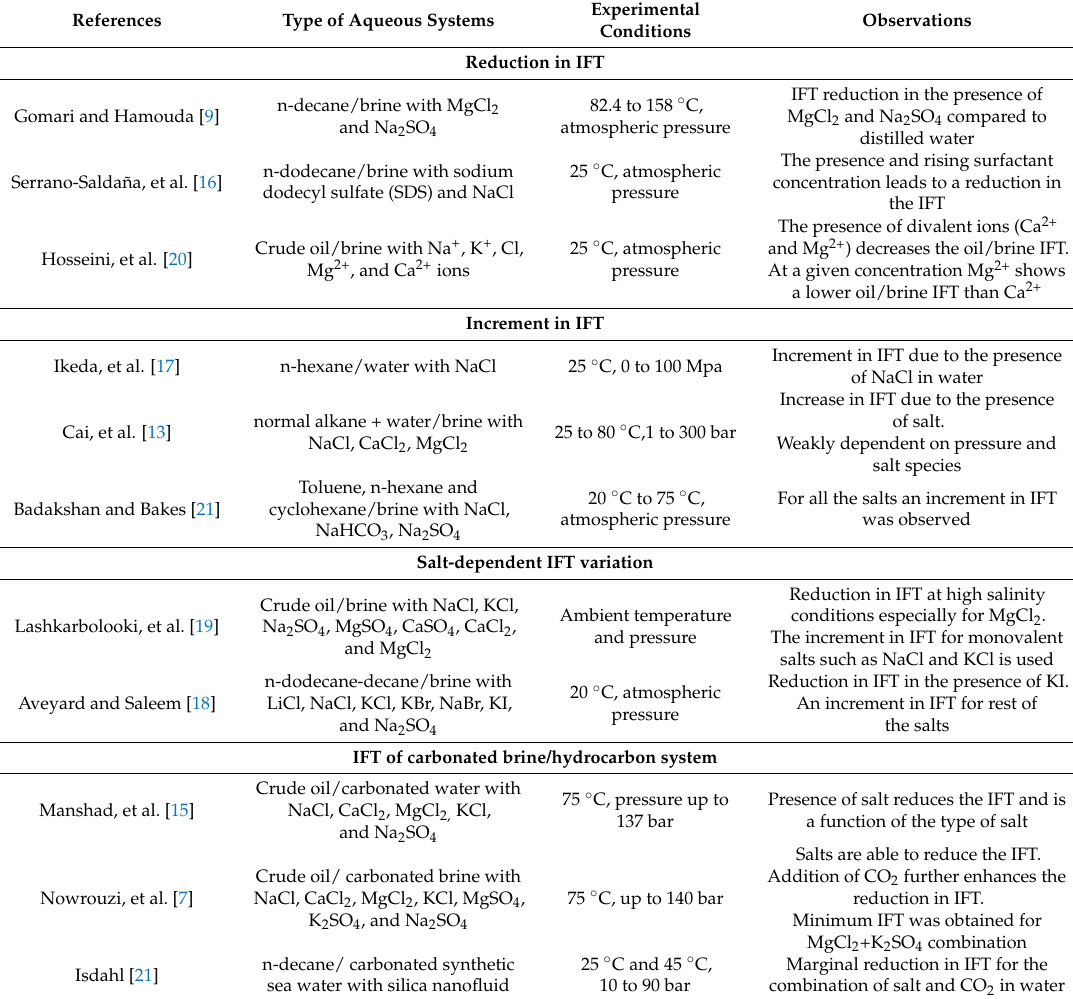
Table 1. IFT obtained by different studies for brine/hydrocarbon and carbonated brine/hydrocarbon